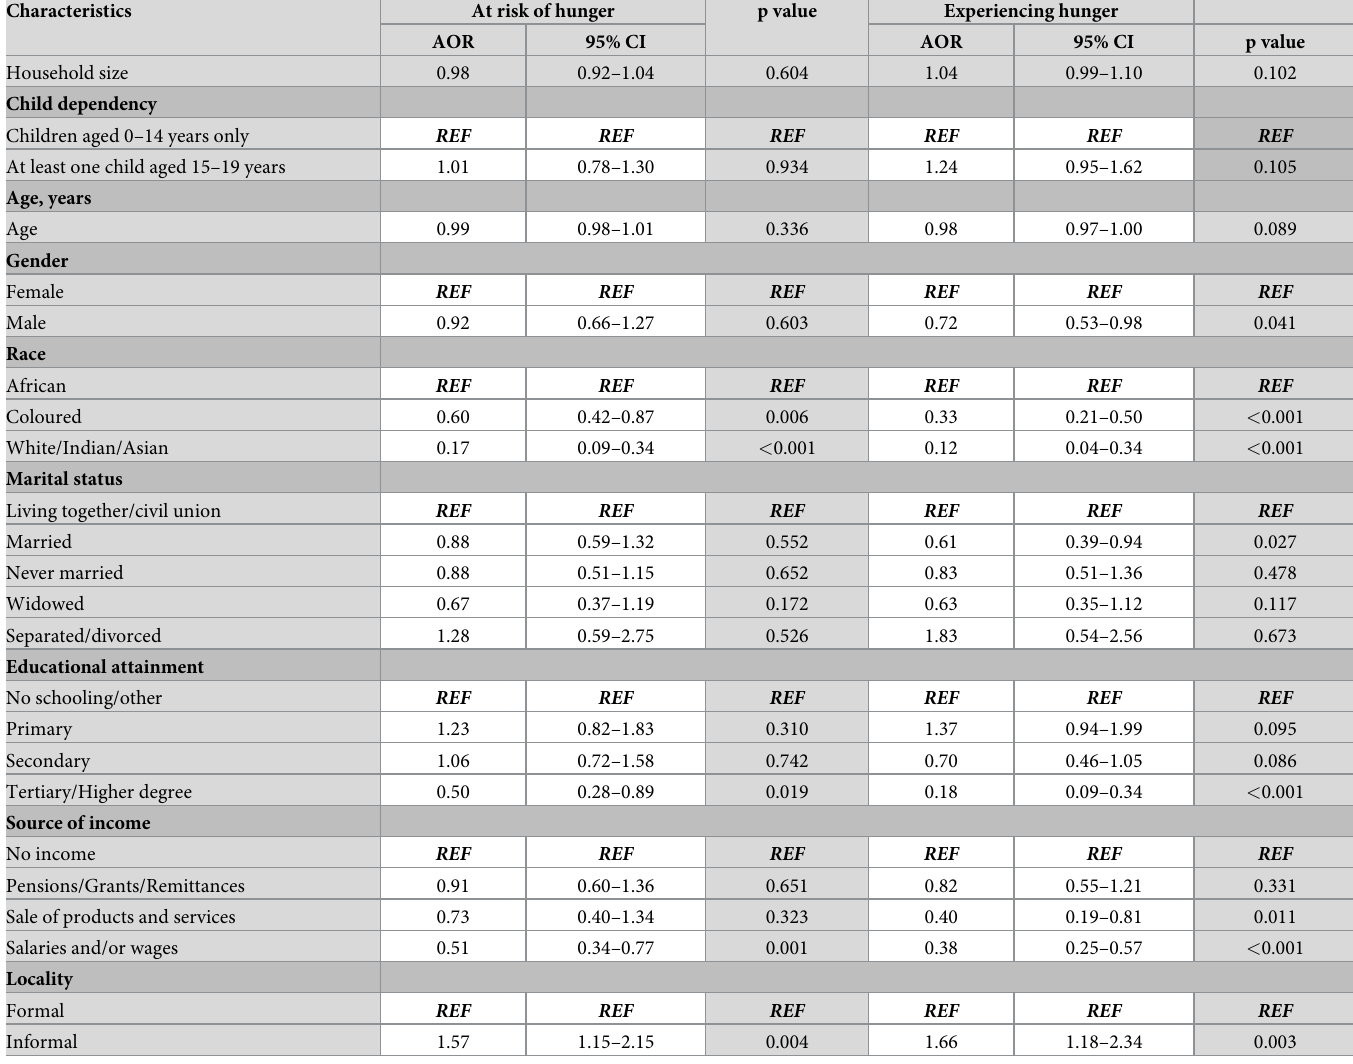
Table 4. Weighted multivariable multinomial regression analysis between food security and child dependency, adjusted for sociodemographic characteristics of the heads of households with